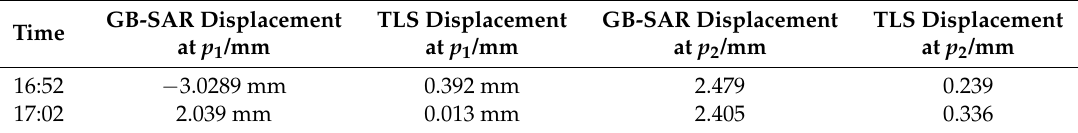
Table 3. GB-SAR and TLS displacement measurement at p 1 and p 2 .